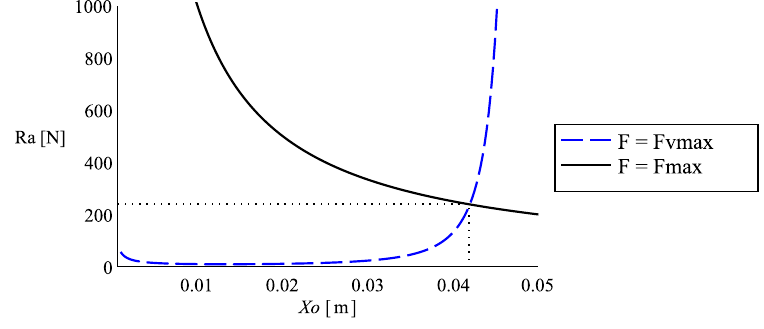
Figure 10. Support force R as a function of support location x . Two plots are shown: a 0 F = F shows the support force if always a force F = F is allowed to be applied on max max the leaf spring, and F = F shows the support force when a certain force, F , is applied v max with which a certain maximum deflection v ( x ) = v is achieved. Their crossing is the max maximum possible support force, R amax